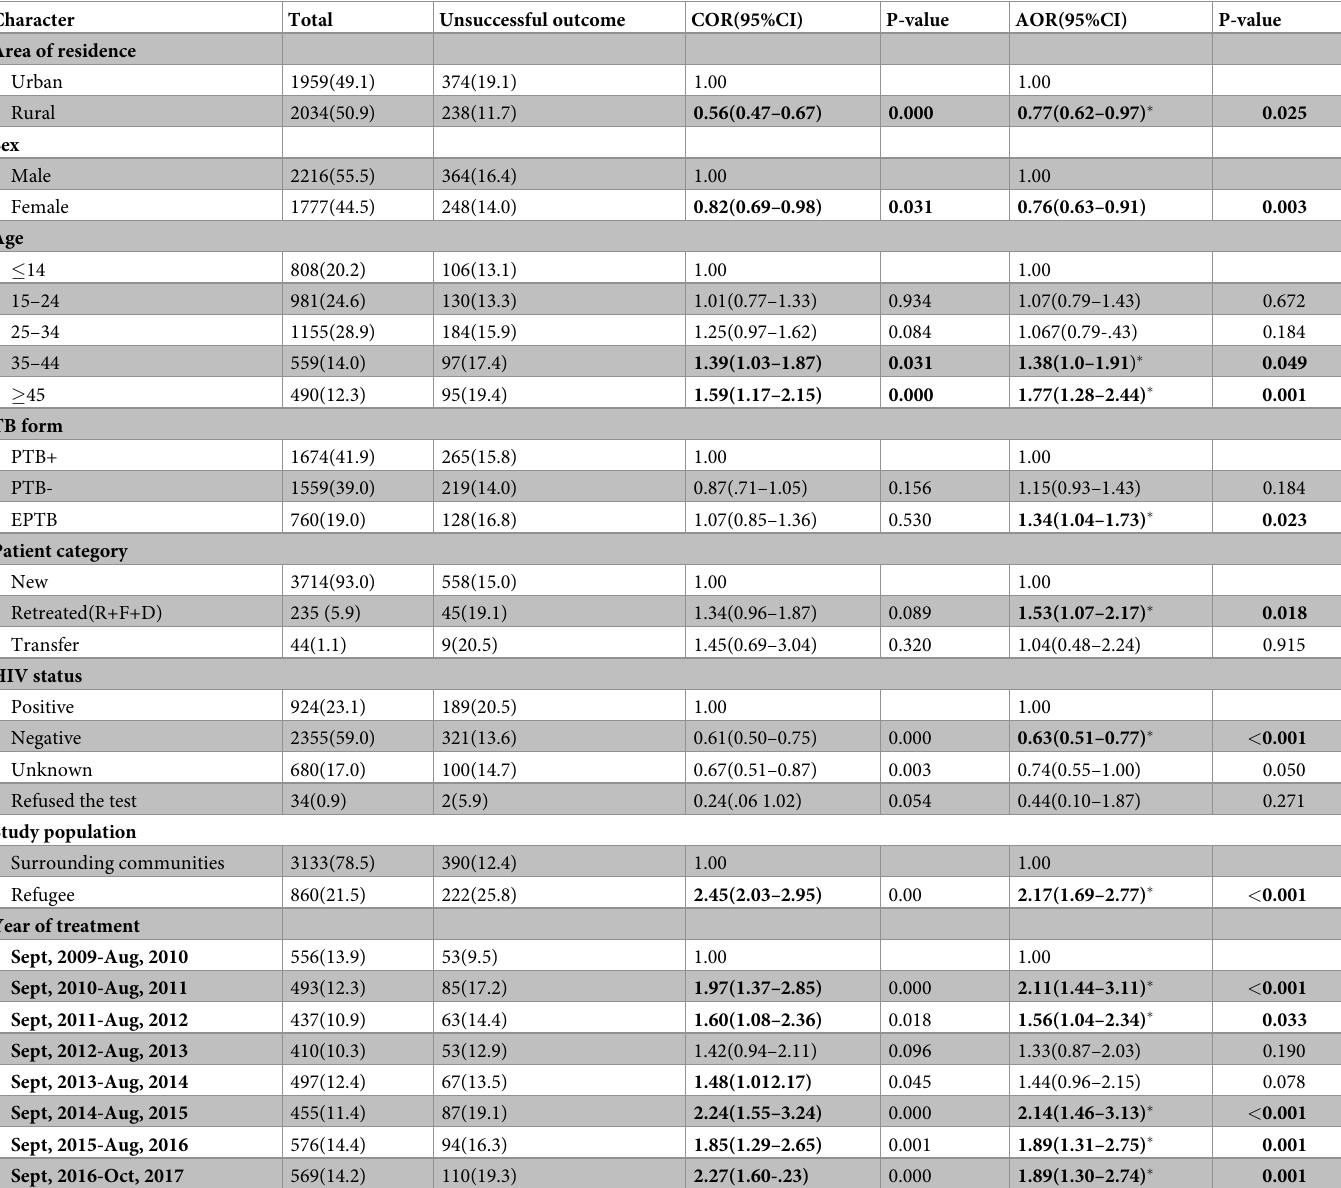
Table 3. Factors associated with poor (unsuccessful)TB treatment outcome among refugees and surrounding communities (SCs) TB cases registered in Gambella Regional State, South West Ethiopia,